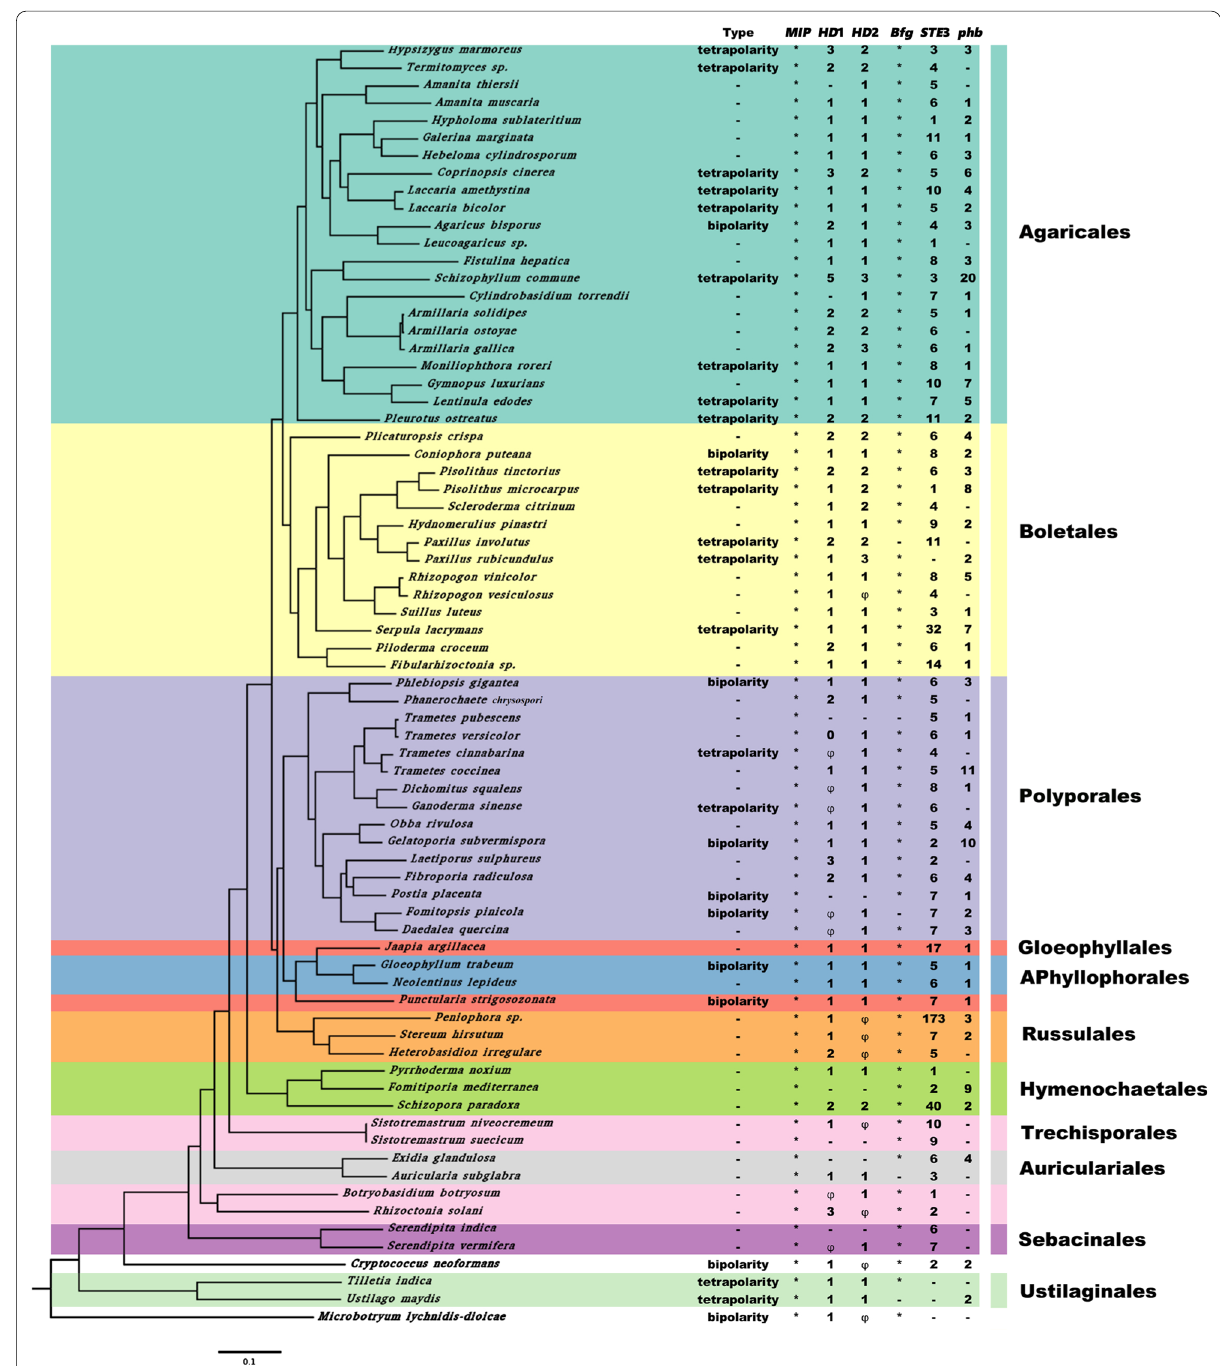
Fig. 3 The phylogenetic trees of 73 fungal species from Basidiomycete species . The right one displays their mating system type and the number of following genes: Mip , HD1 , HD2 , Bfg STE3 and phb . “φ” is representative of MAT-2 , and "-" means the gene has not been